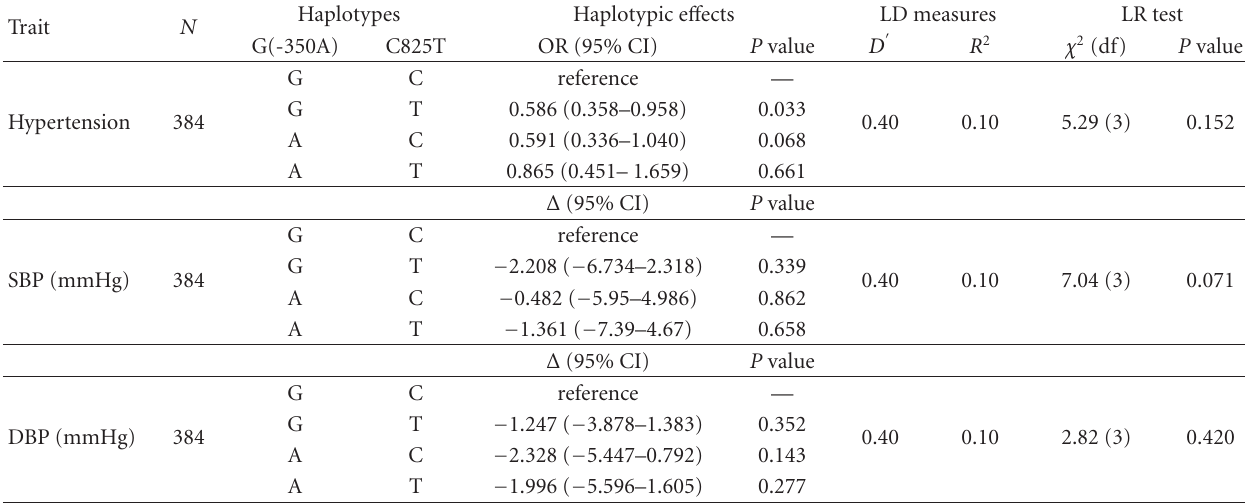
Table 6: Analysis of haplotypic e ff ects (G-350A/C825T) on blood pressure-related phenotypes. Trait